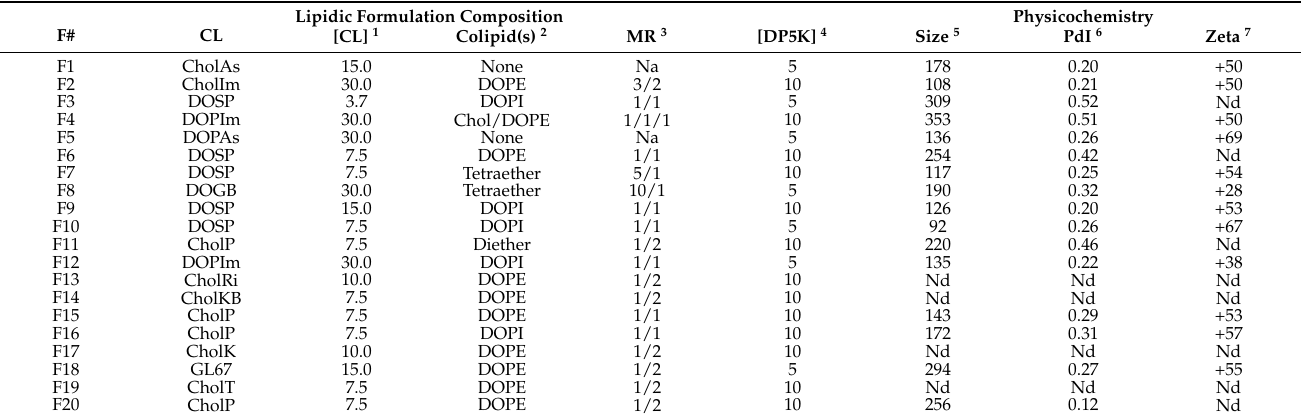
Table 2. Composition and physicochemical characterizations of